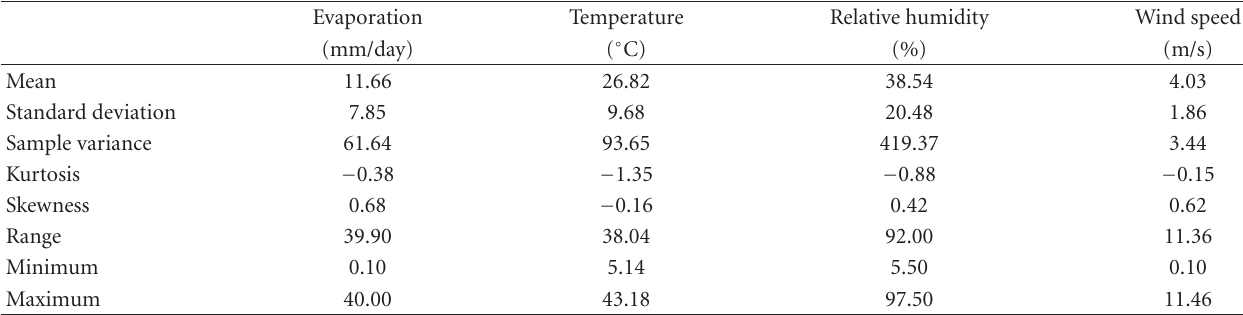
Table 1: Descriptive statistics of daily average meteorological data for Kuwait from 1993 to 2009.